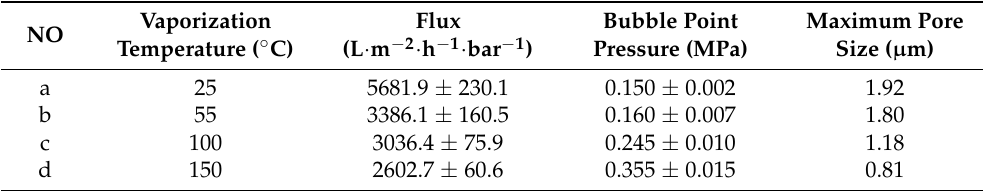
Figure 5. Effect of evaporation temperature on the cross-section and surface microstructure of membranes. Table 6. The properties of membrane prepared under different evaporation temperature.